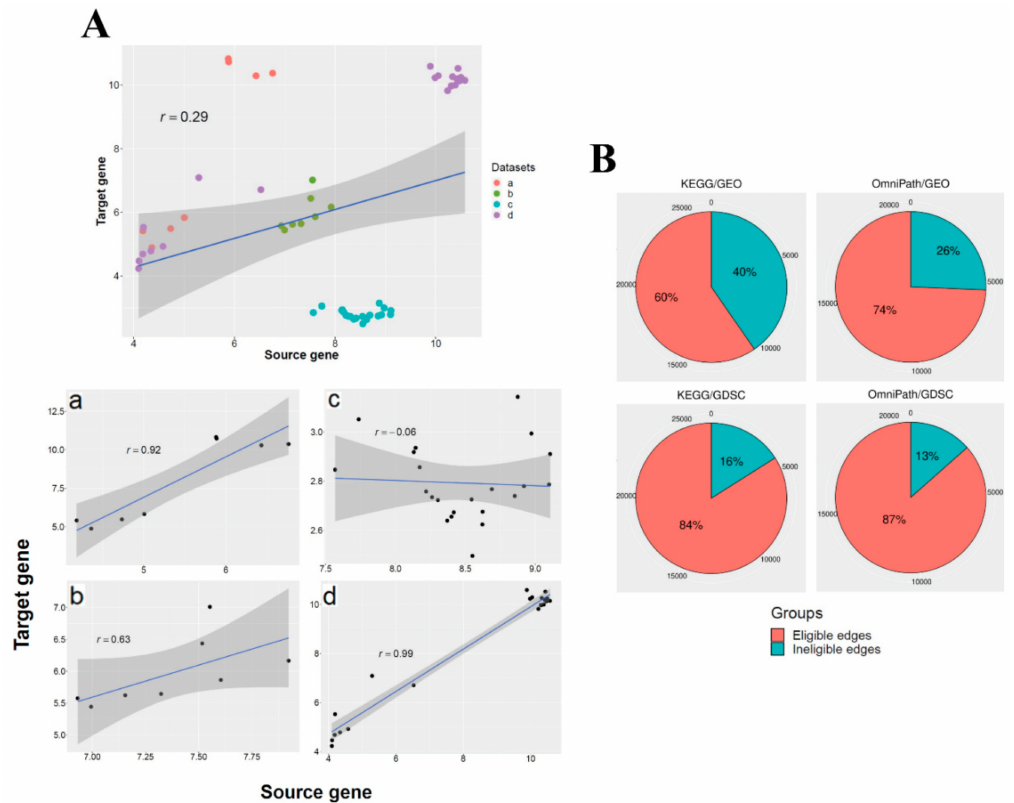
Figure 2. ( A ) An exemplary relationship between gene pair expression. These scatter plots contain the Pearson coe ffi cient correlations and fitted linear regression line. The X-axis and Y-axis values di ff er according to the expression profile of this gene pair in di ff erent gene expression datasets. The gene expression profiles of these exemplary gene pairs in the edge list before pre-processing are depicted. The same gene pairs’ expression profiles were separated according to the four relevant datasets. ( B ) The proportion of eligible and ineligible edges in the four parallel analyses. The numbers around each chart represent the number of edges at that